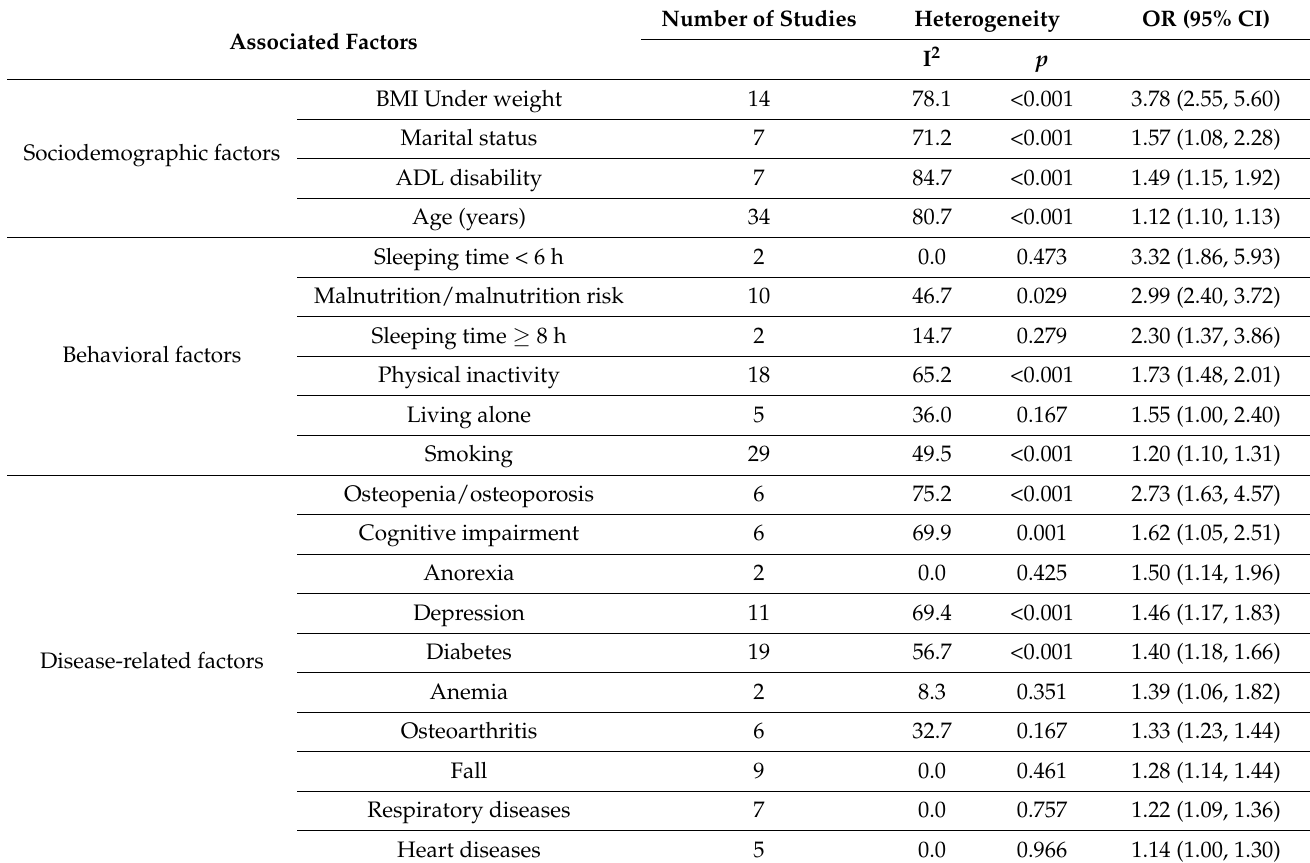
OR = 1.10, 95% CI: 0.80–1.51, Figure S5), male (11 studies, OR = 1.50, 95% CI: 0.96–2.34, Figure S6), higher level of education (11 studies, OR = 0.95, 95% CI: 0.92–0.98, Figure S7), and high BMI (overweight/obesity) (12 studies, OR = 0.27, 95% CI: 0.17–0.44, Figure S8) were not associated with sarcopenia. (Table 2). Table 1. Pooled ORs and 95% confidence interval for associated factors of sarcopenia in community-dwelling older adults. Number of Associated Factors